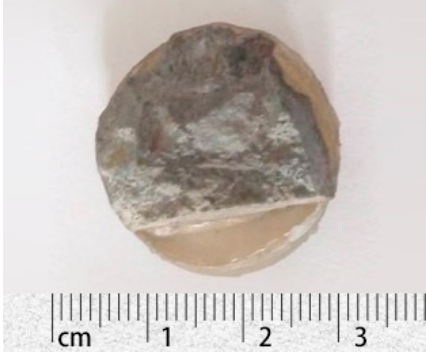
Figure 5. The SEM specimen. Figure 5. The SEM